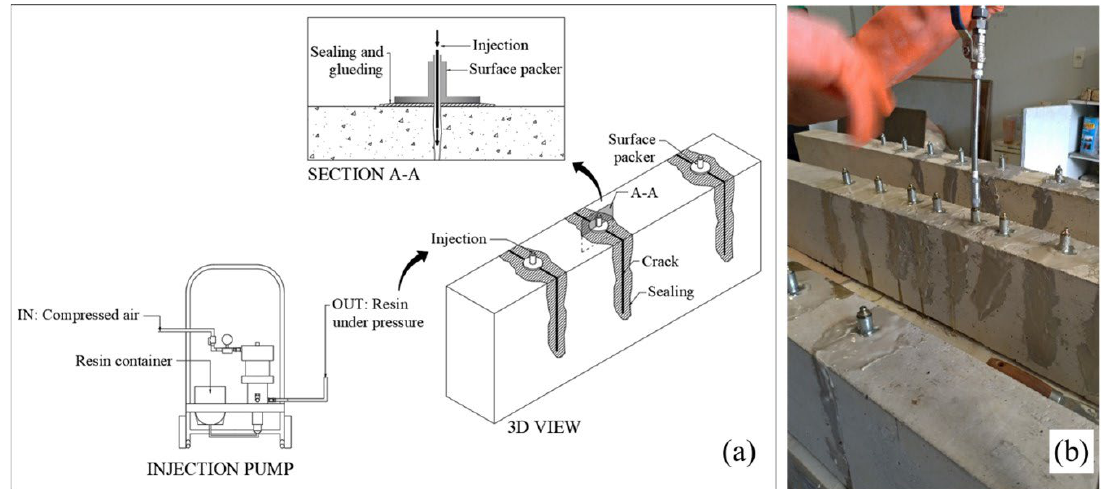
Figure 6. General schematics of crack injection in the models (a); crack injection procedure (b)